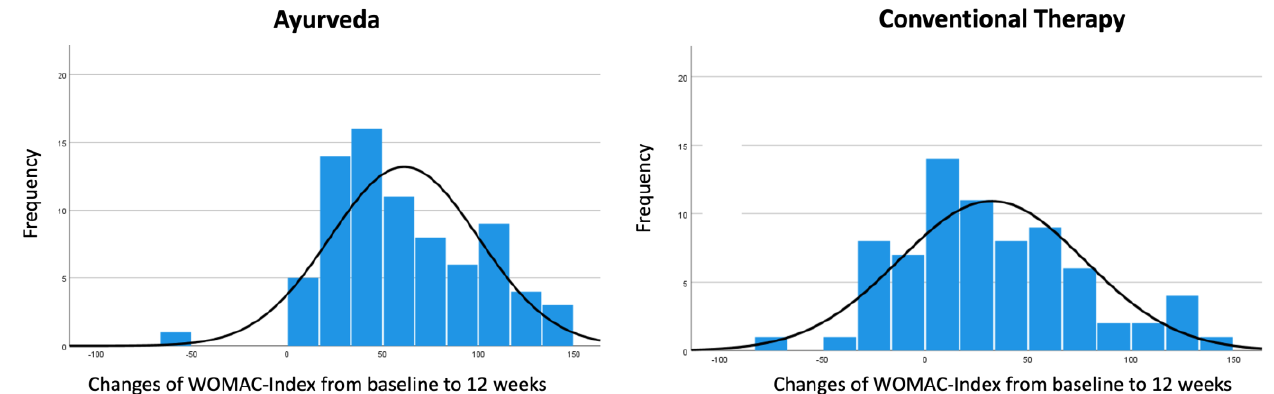
Figure 1. Frequency distribution of the changes in the WOMAC Index from baseline to 12 weeks with normal curve. Values > 0 of changes in the WOMAC Index indicate improvements, while values < 0 indicate worsening.